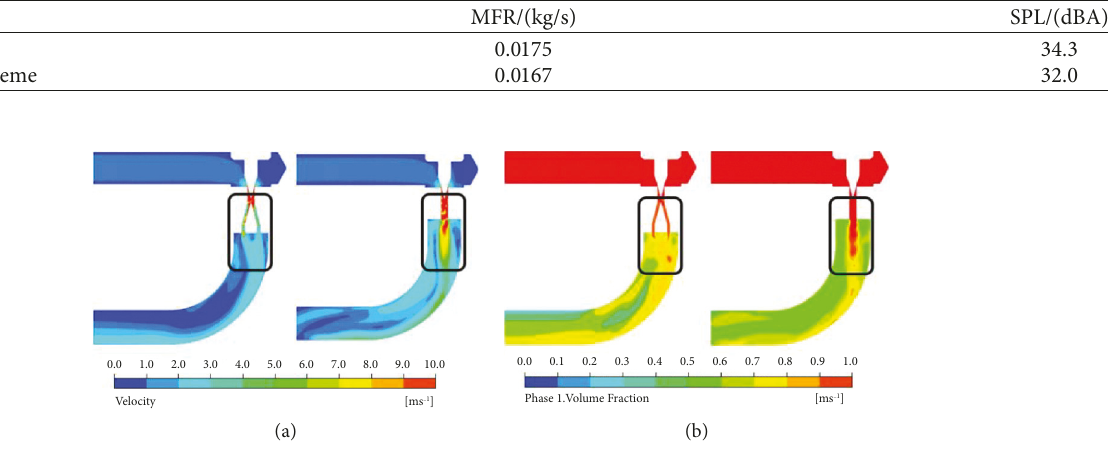
Figure 12: Contour of velocity (a) and liquid phase fraction (b) (The improved scheme is on the left while the prototype is on the right in each part).